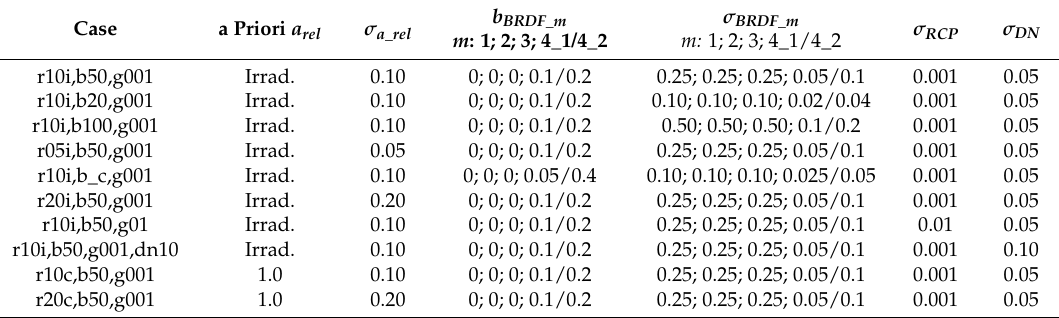
Table 5. A priori values and standard deviations for the observations used in the calculations. a rel : relative image-wise correction parameters; Irrad.: median irradiance observation; σ a _ rel : standard deviations of a rel ; b BRDF _ m : a priori values of the BRDF parameters; σ BRDF _ m : standard deviations of the BRDF parameters 1, . . . , 4; p4_1: p4 settings for bands 1–23; p4_2: p4 settings for bands 24–35; σ RCP : standard deviation of radiometric control point; σ DN : standard deviation of image